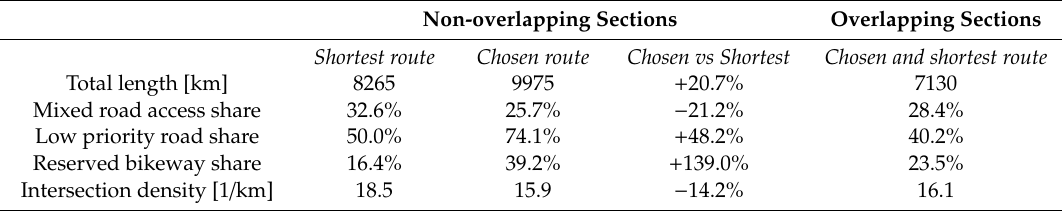
Table 1. Road link attributes of chosen and shortest routes of non-overlapping sections and on overlapping